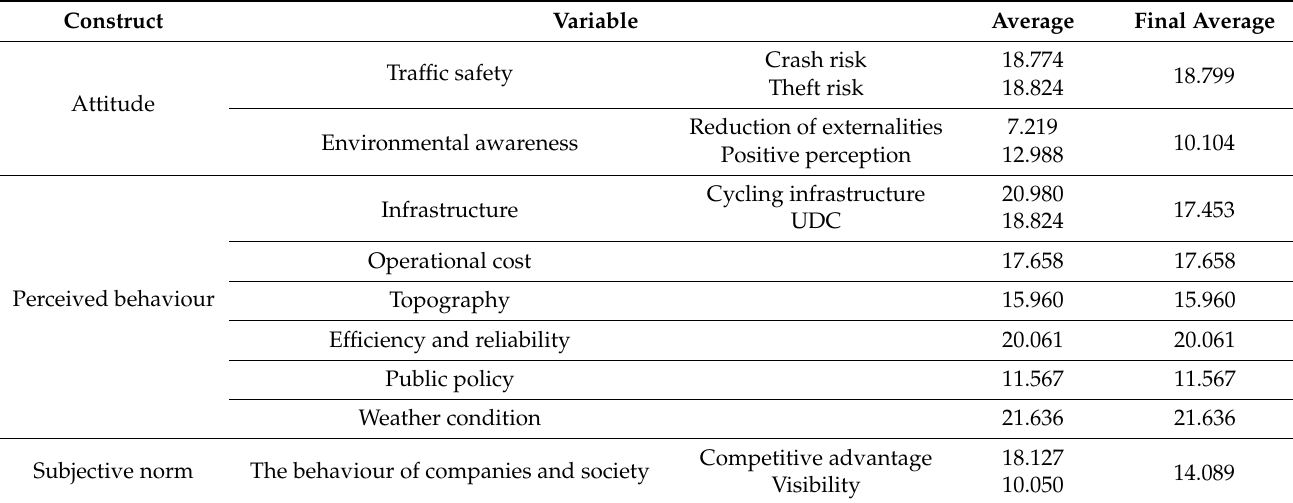
Table 2. Identifying behavioural